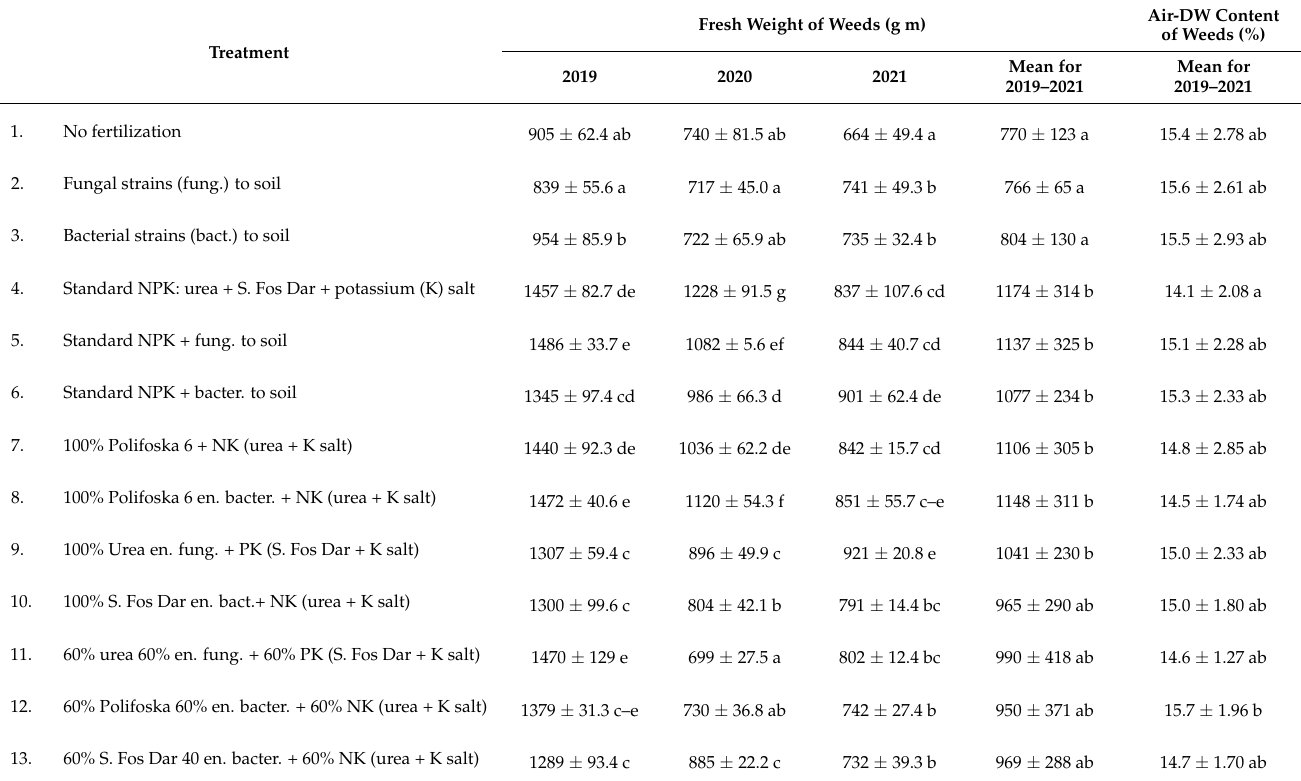
Table 4. Fresh weight of weeds and air-DW content of weeds in the apple orchard, 2019–2021.